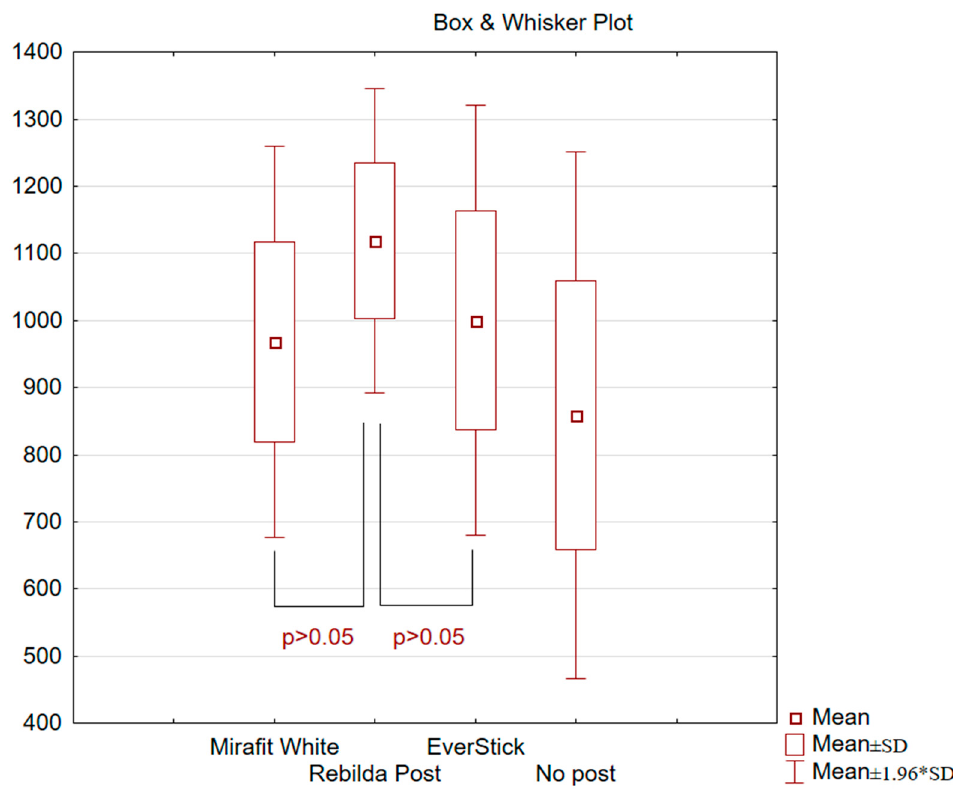
Figure 4. Mean fracture damage values, standard deviations (SD). Table 2. Prognosis of tooth restoration possibilities after conducted strength